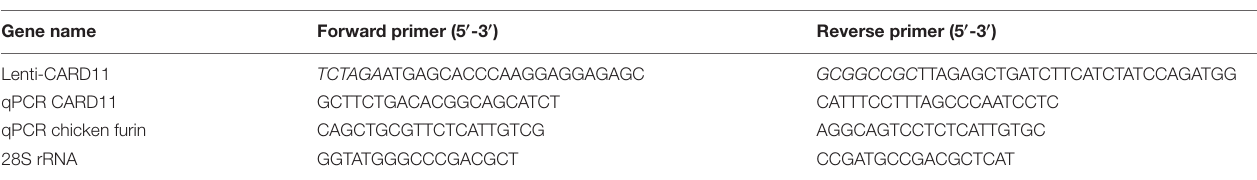
( Table 1 ) and ligated into